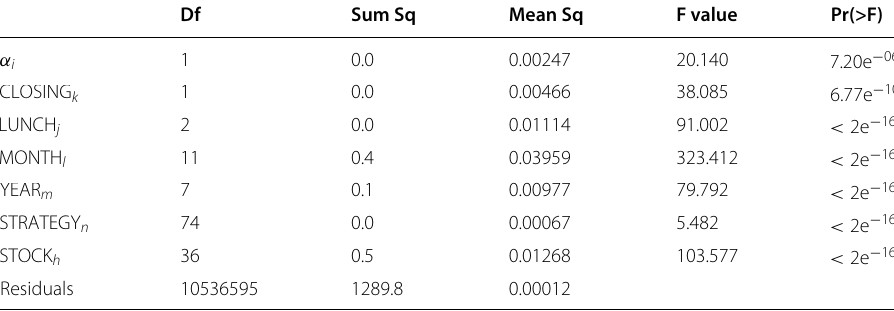
Table 3 Results for the ANOVA model